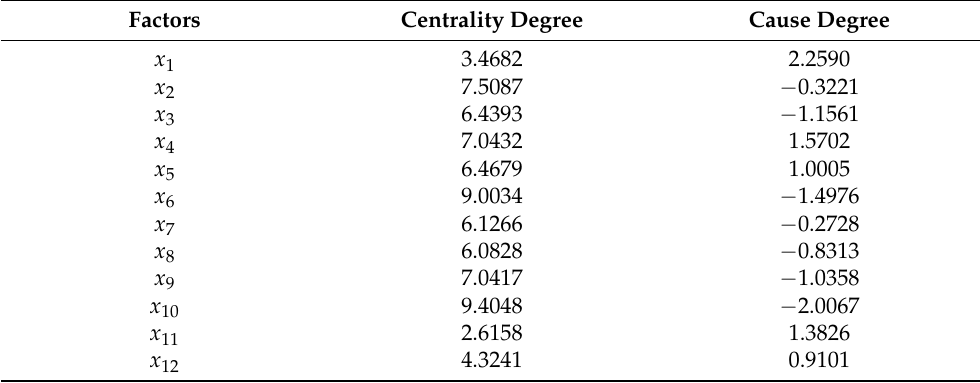
Calculating Table 3 according to Formulas (4)–(7), the centrality degree and cause degree of each influencing factor can be obtained, as shown in Table 4. Table 4. Calculation results of centrality and cause